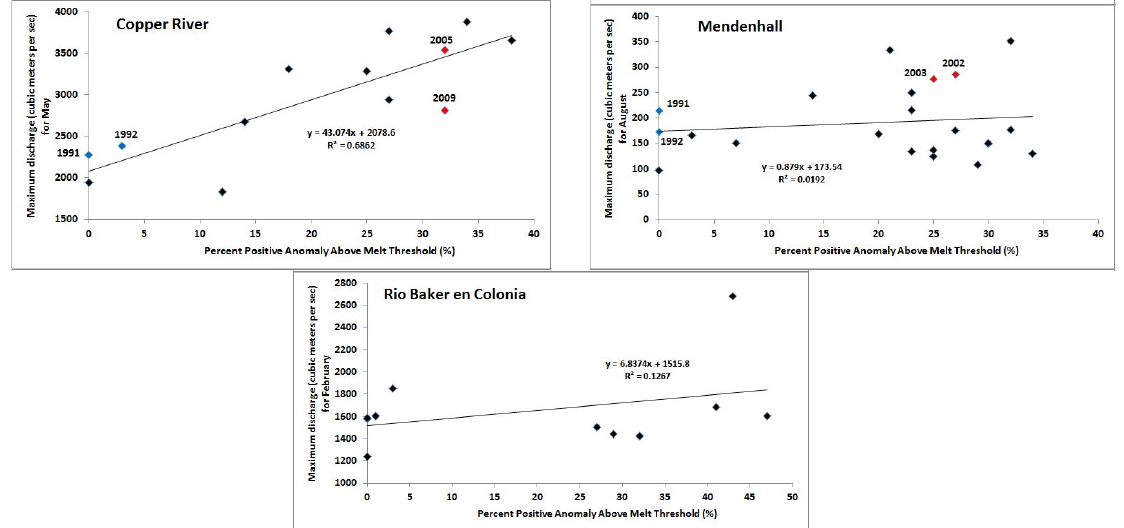
The high and low anomaly years illustrated in Figures 8 and 9 are labeled and colored red and blue, respectively, for Copper River and Mendenhall